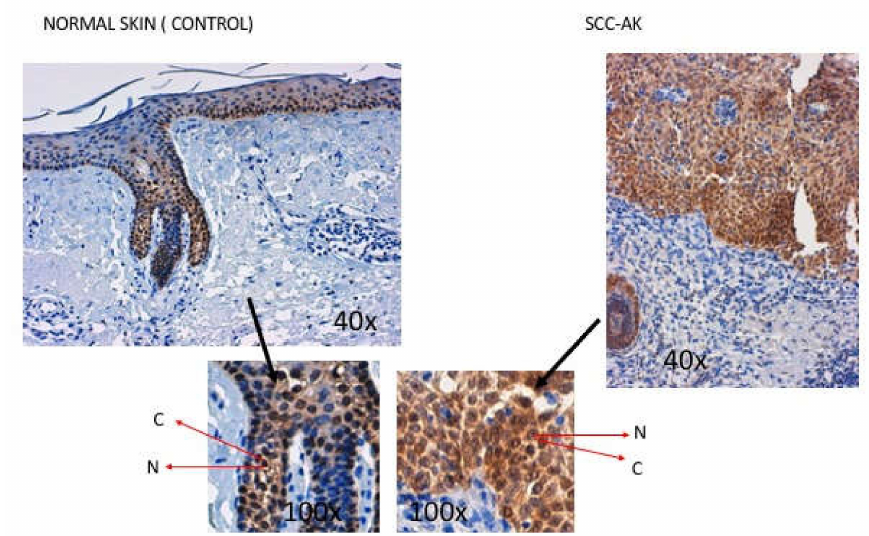
Figure 1. Immunohistochemistry analysis showing heat shock protein 70 (Hsp70) expression in control and squamous skin cell carcinoma arising from actinic keratosis (SCC-AK) samples with infiltration levels II and III. Abbreviations: nucleus (N) and cytoplasm (C).